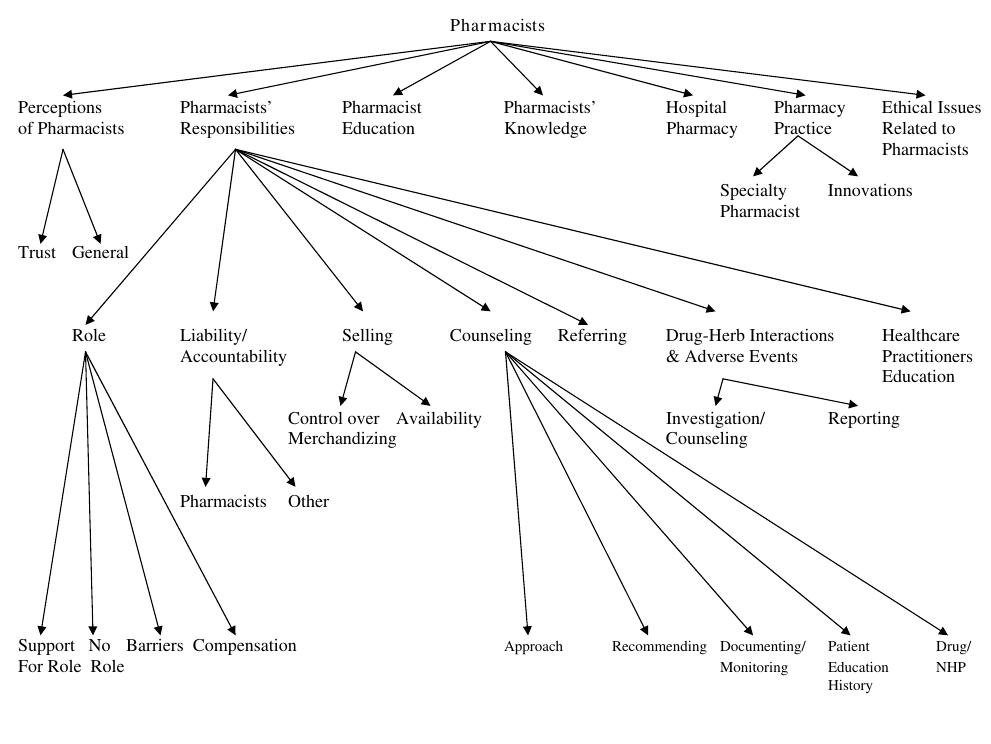
Pharmacist coding tree Figure 1